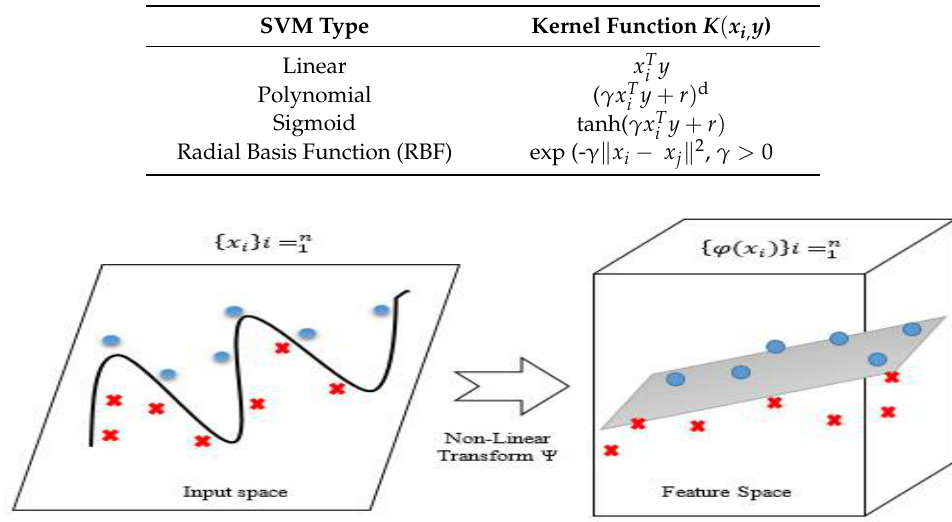
Table 1. Kernel functions in support vector machines (SVMs).